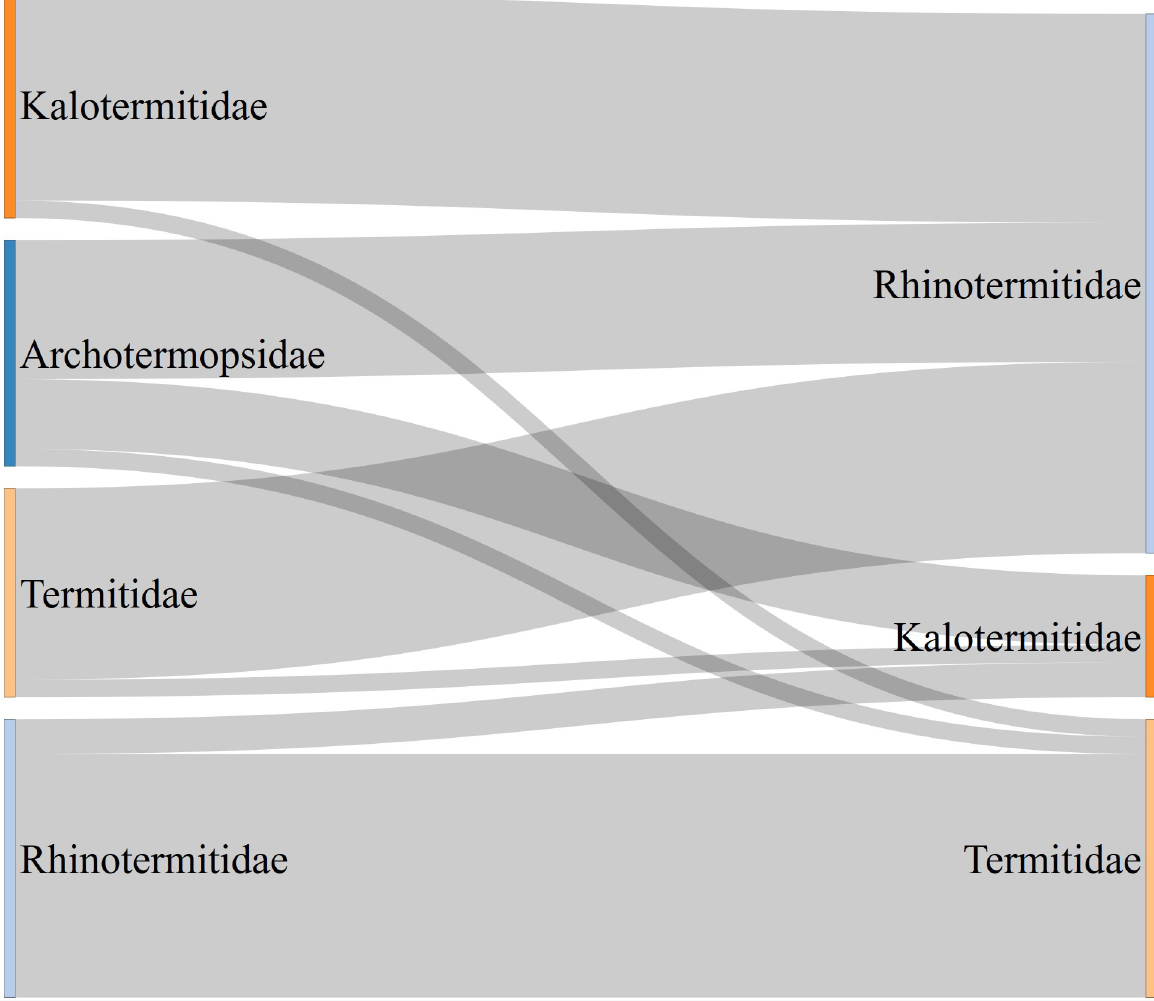
Fig 6. Corrections (right side) of incorrect family classifications (left side) for 54 termite records. Bandwidth is proportional to the number of corrected observations. All four Stolotermitidae records had correct family names, which is why this family is not shown on the left side.